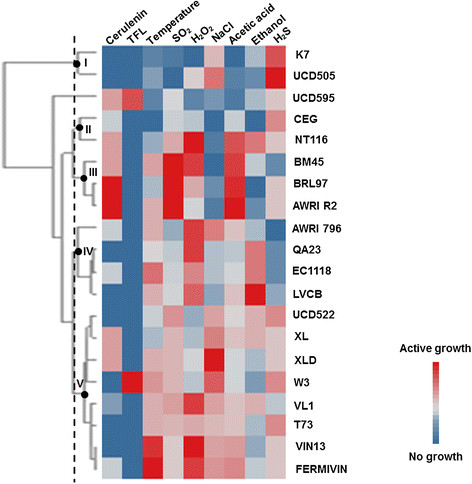
Phenotypic variation in the 20 commercial yeast strains. The strains were grown at least in duplicate on solid agar plates with 1–3 doses of each environmental variable, as described in Material and Methods. Each row on the plot represents a different strain, and each column indicates a particular environment. The colored boxes represent the average growth score of each strain in each environment, as in the legend shown at the lower right. For H2S, the color gradient indicates the color intensity of the colonies on the BIGGY agar, low or absent (blue) and high (red).